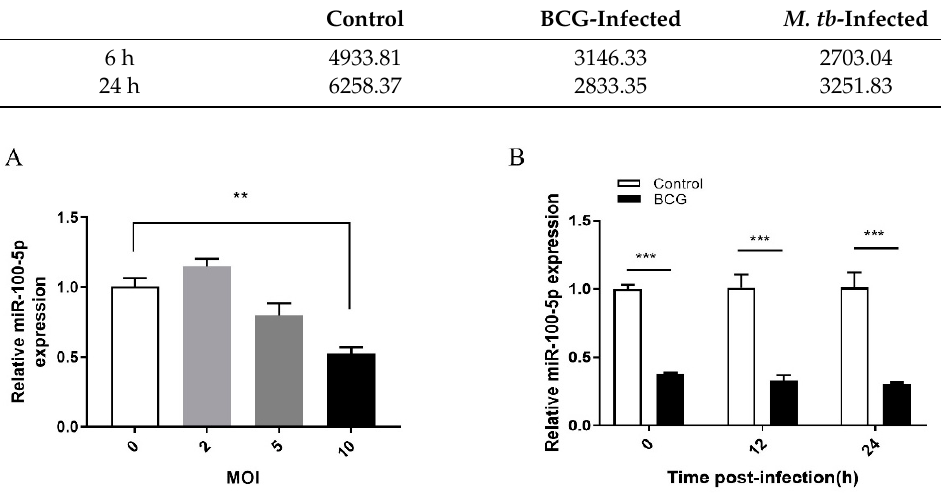
Figure 1. miR-100-5p expression in BCG-infected THP-1 cells. ( A ) PMA-differentiated THP-1 cells were infected with BCG at MOIs of 2, 5, and 10 for 8 h. Total RNA was extracted at 24 hpi. The miR-100-5p expression level was measured by qRT-PCR normalized with U6 as the internal reference. ( B ) PMA-differentiated THP-1 cells were infected with BCG at an MOI of 10 for 8 h. Total RNA was extracted at 0, 12, and 24 hpi. The miR-100-5p expression level was measured by qRT-PCR normalized with U6 as the internal reference. Data are representative of three independent experiments with biological duplicates in each (( A , B ); mean ± s.e.m. for n = 3 duplicates). ** p < 0.01; *** p < 0.001 (ANOVA).